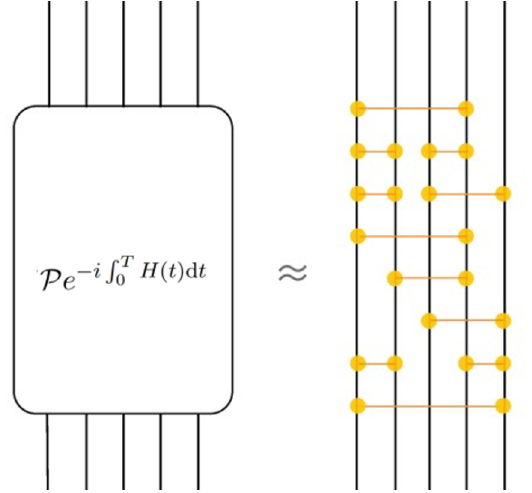
Figure 4 . Each line represents a qubit and edges connecting two lines refer to local gates.